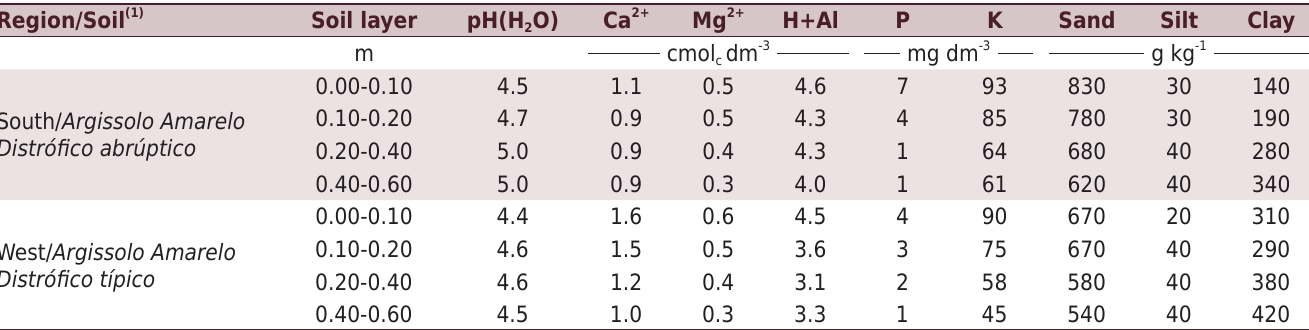
calcium acetate 0.5 mol L -1 , buffer at pH 7.0; P and K extracted with Mehlich-1 solution; sand, silt, and clay determined by the pipette method (Ruiz,